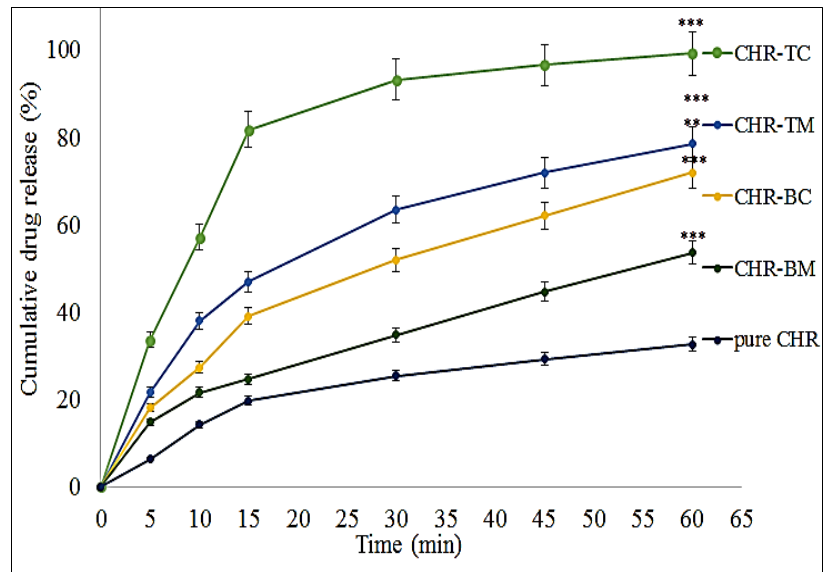
Figure 2. The dissolution profile of pure Chrysin (CHR), Chrysin binary mixture (CHR-BM), Chrysin binary complex (CHR-BC), Chrysin ternary mixture (CHR-TM), and Chrysin ternary complex (CHR-TC). The study was performed thrice, and results were shown as mean ± SD. *** highly significant to pure Chrysin; ** significant to Chrysin ternary mixture.